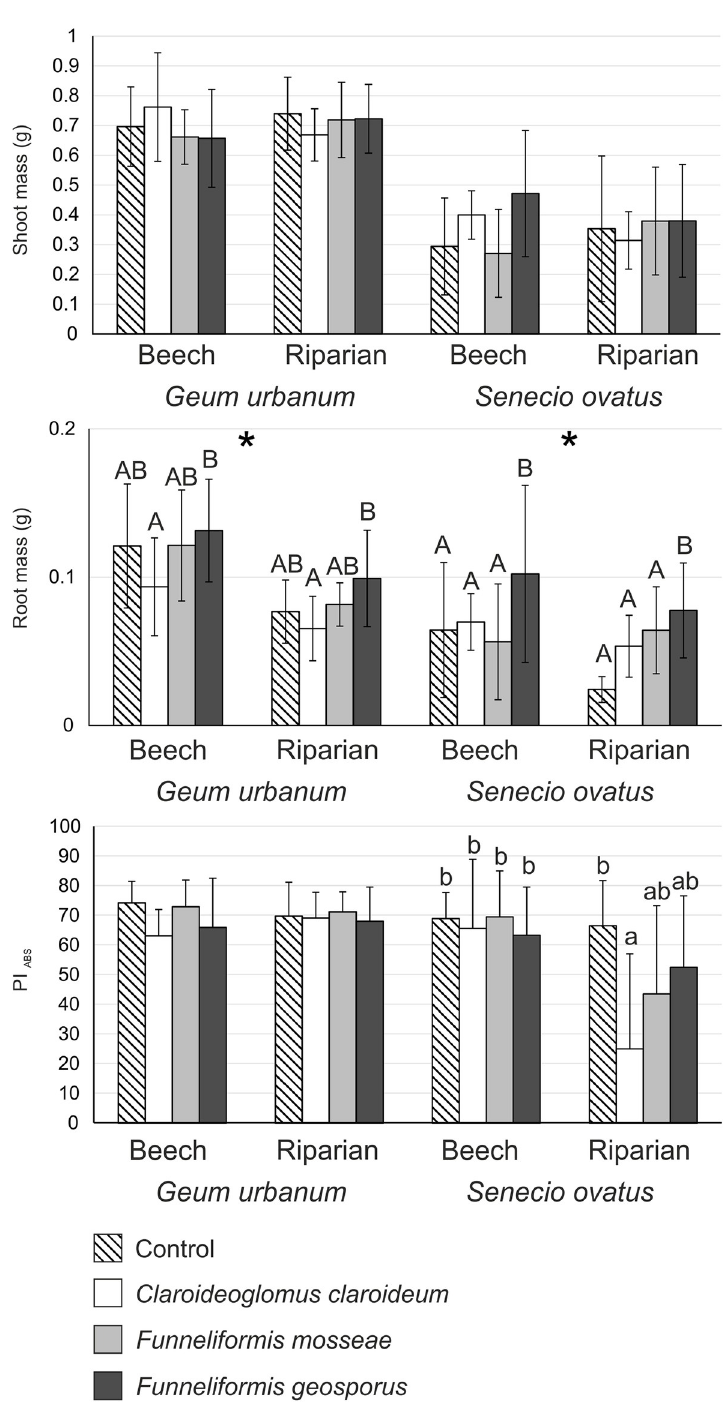
Fig 2. Shoot and root dry mass (grams; mean ± SD) and photosynthetic performance index (PI ABS ; mean ± SD) of Geum urbanum and Senecio ovatus grown in beech and riparian soils. Within each plant species, lowercase letters above the bars indicate statistically significant interaction between fungus and soil effects; uppercase letters indicate the significant main effect of fungus; different letters above the bars indicate statistically significant differences; the asterisk ( � ) indicates the significant main effect of soil; for each, p < 0.05. See Table 2 for details on the main effects and